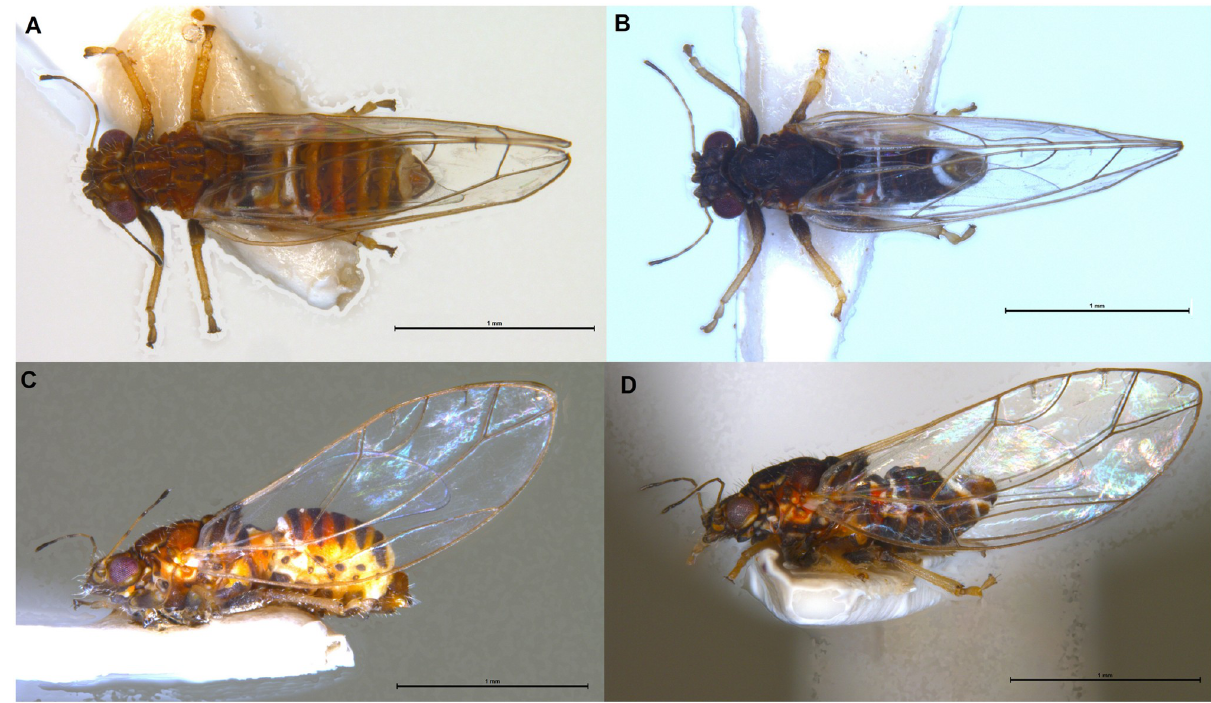
Fig 2. Adults of Trioza melaleucae . Habitus dorsal of female ( A ) and male ( B ); habitus lateral of female ( C ) and male ( D ). The scale bars are 1 mm. Melaleuca alternifolia ’ {Printed on white card}. ‘PARATYPE ♂ - ♀ / Trioza melaleucae / Mar- toni 2021’ {Printed on blue card}; 2 ♀ , 2 ♂ deposited at the ANIC . Entire specimen mounted on card triangle. Labels: ‘Australia, NSW / Teven / 28˚50’51.5"S 153˚29’10.5"E / Nov 2020 P. Entwistle / On Melaleuca alternifolia ’ {Printed on white card}. ‘PARATYPE ♂ - ♀ / Trioza mela- leucae / Martoni 2021’ {Printed on blue card}; 1 ♀ , 1 ♂ deposited at the VAIC . Dissected speci- men mounted on microscope slide. Labels: ‘Australia, NSW / Teven / 28˚50’51.5"S 153˚ 29’10.5"E / Nov 2020 P. Entwistle / On Melaleuca alternifolia ’ {Printed on white card}. ‘PARA- TYPE ♂ - ♀ / Trioza melaleucae / Martoni 2021’ {Printed on blue card}. 1 ♀ , 1 ♂ deposited at the VAIC . Dissected specimen mounted on microscope slide. Labels: ‘Australia, QLD / Dim- bulah / Nov 2020 S. Stow / On Melaleuca alternifolia ’ {Printed on white card}. ‘PARATYPE ♂ - ♀ / Trioza melaleucae / Martoni 2021’ {Printed on blue card}.